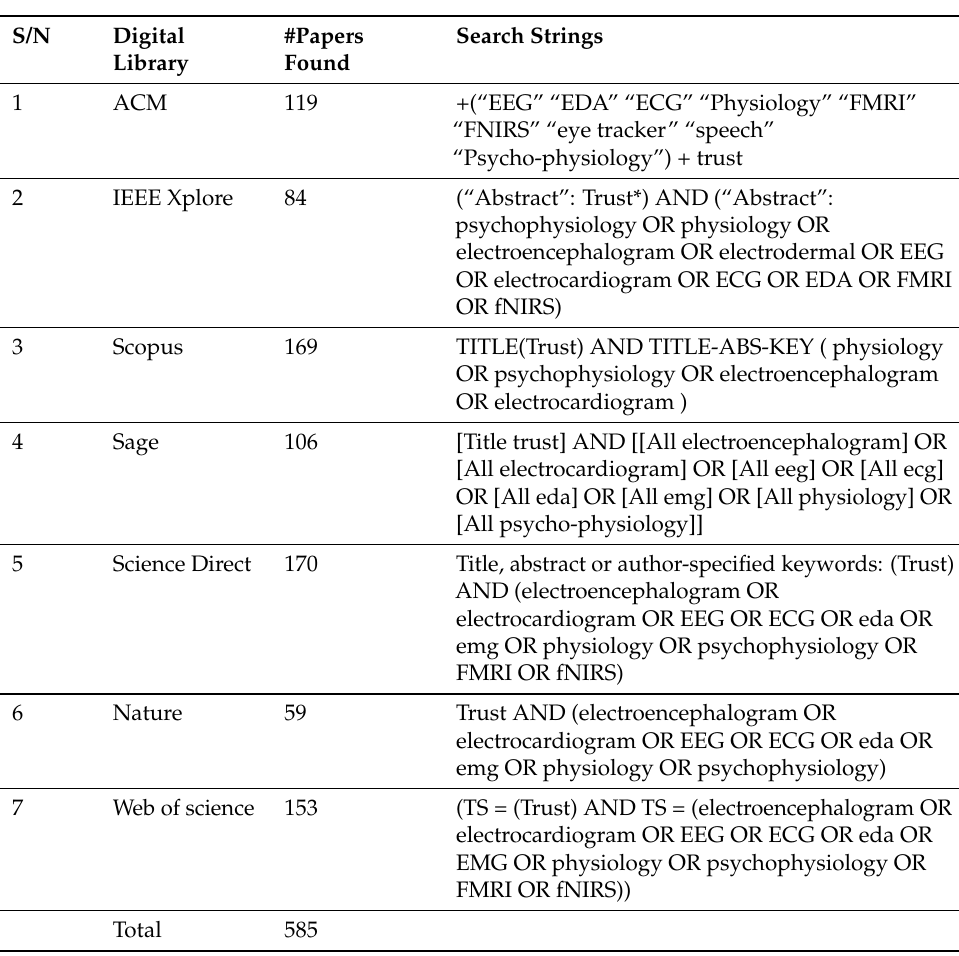
Table 3. Papers retrieved from the selected digital